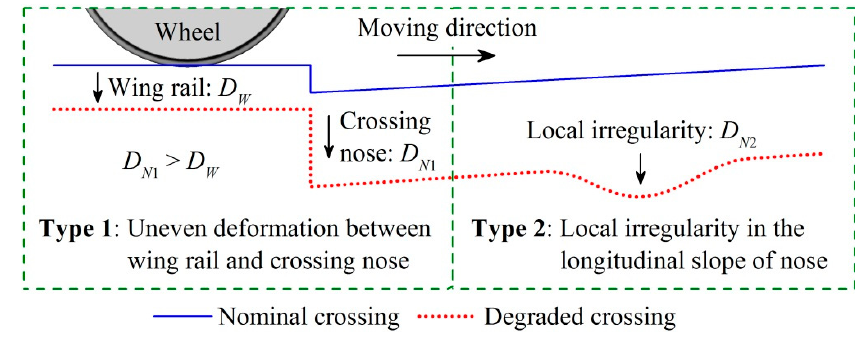
D denotes the difference in the Figure 8. Two types of degradation at the measured crossing. W Figure 8. Two types of degradation at the measured crossing. D W denotes the difference in the height D and D denote the difference in the height of the crossing nose. height of the wing rail, while of the wing rail, while D N 1 and D N 2 denote the difference in the height of the crossing 1 N 2 N